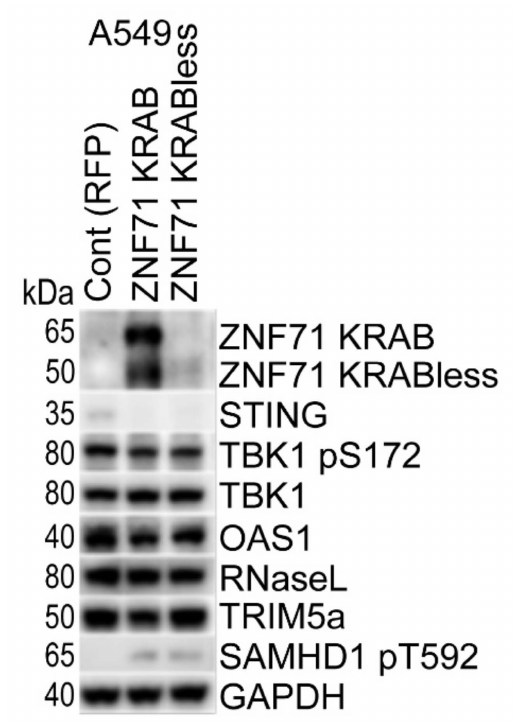
Figure 4. ZNF71 suppresses components of the innate and intrinsic immune response. Western blotting of control RFP, ZNF71 KRAB, and KRABless isoforms overexpression, as well as of several markers of intracellular innate and intrinsic immune systems in A549 cells. GAPDH is shown as the loading